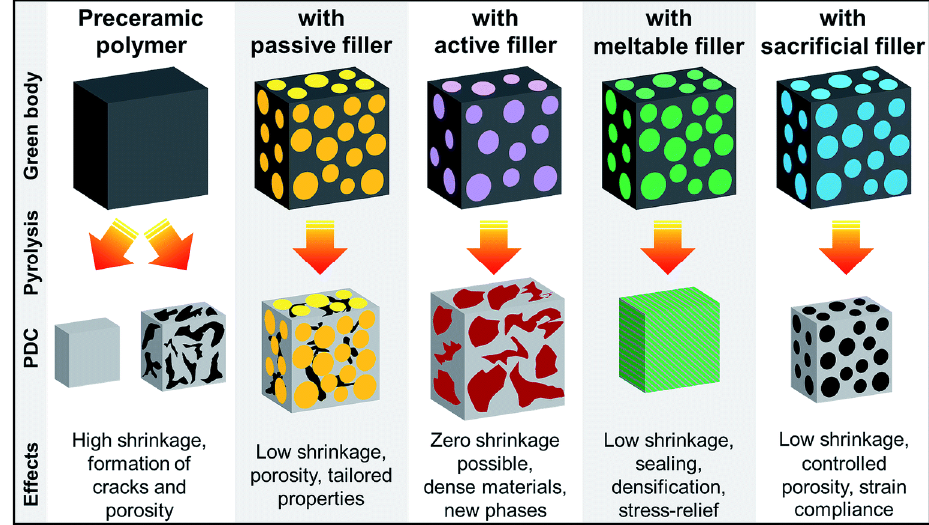
Fig. 12 Effects of different fillers on the polymer-derived ceramic coating systems. Reproduced with permission from Ref. [88], © The Royal Society of Chemistry